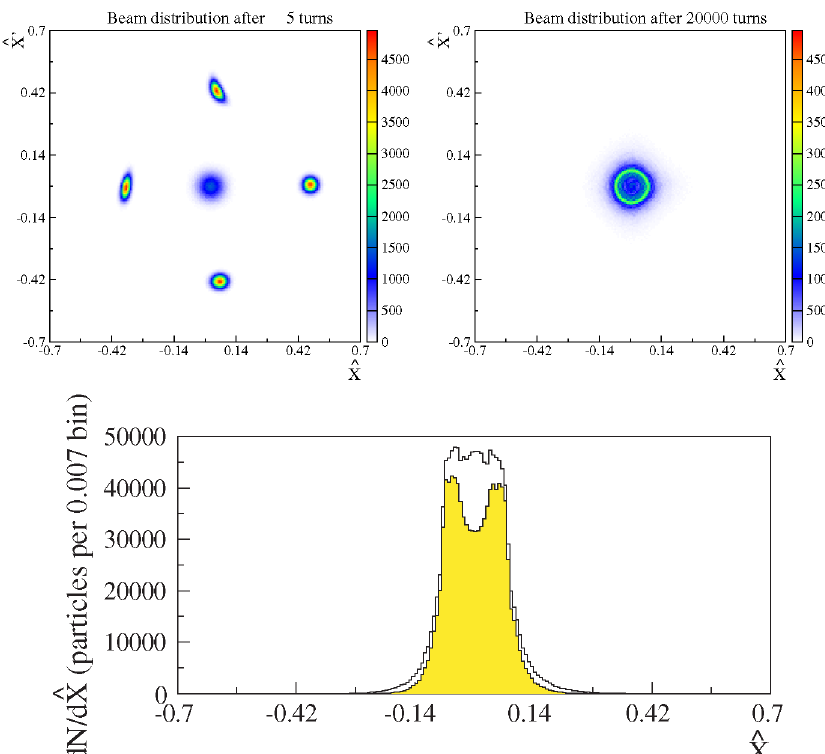
FIG. 3. (Color) Final distribution function for a variant of the proposed four-turn injection with a fifth injected turn so to generate an almost uniform distribution. The beam distribution after the end of the injection process is shown on the upper left part, while the final distribution is reported on the upper right part. The projected beam distribution is shown in the lower part: the final profile for the configuration plotted in Fig. 2 is also shown for comparison (shaded